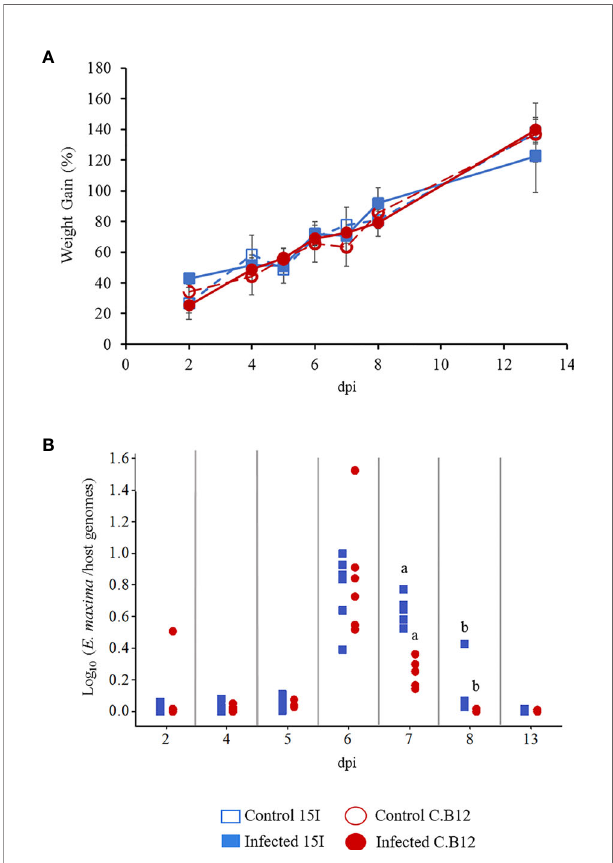
FIGURE 1 | Body weight gains and parasite replication in line C.B12 and 15I chickens following E. maxima infection. Three-week-old birds were orally infected with 100 sporulated E. maxima oocysts ( n = 5 per line) or sterile water ( n = 3 per line). (A) Percentage of body weight gains were calculated for individual birds from 2 days prior to inoculation to time of culling at time points as indicated. The results were presented as the mean percentage of body weight gain and error bars represent standard deviation. (B) Eimeria maxima replication was quanti fi ed by qPCR targeting the MIC1 gene. The results were presented as the ratios of parasite genome vs host genome copy numbers for individual birds. Matching letters indicate signi fi cant differences between the two lines at p < 0.05 on the same day ( n = 5 per time